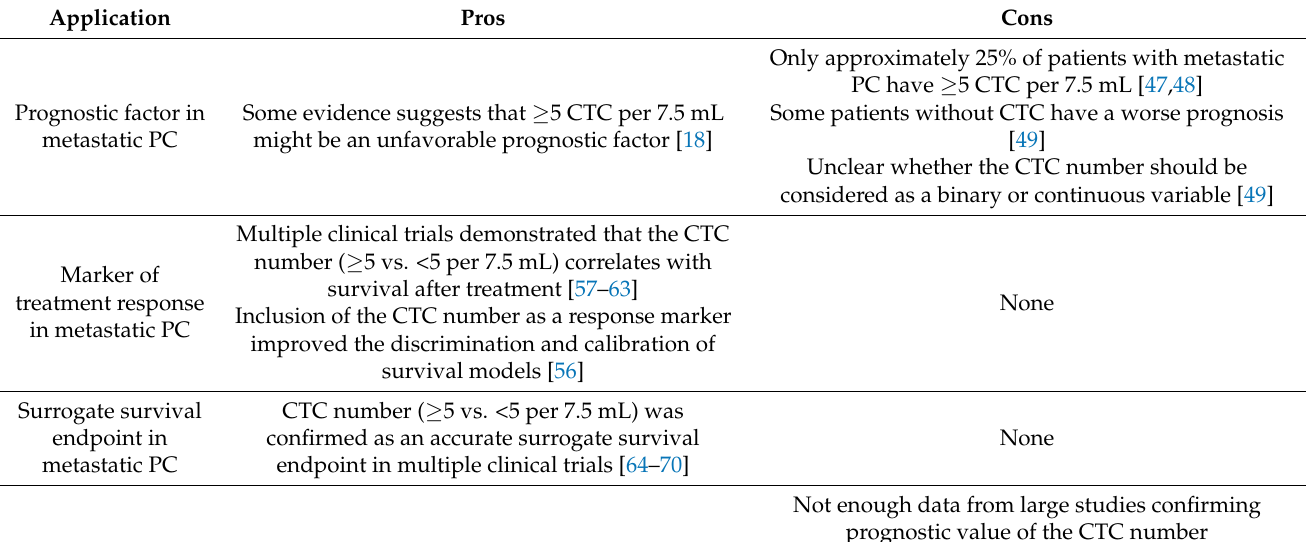
Table 1. Summary of pros and cons for various applications of CTC enumeration in prostate cancer (PC)